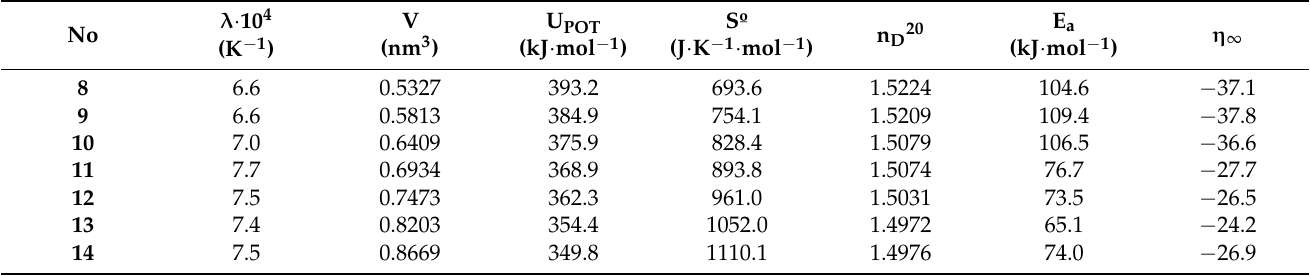
Table 4. Various physicochemical parameters calculated for ILs 8 – 14 .